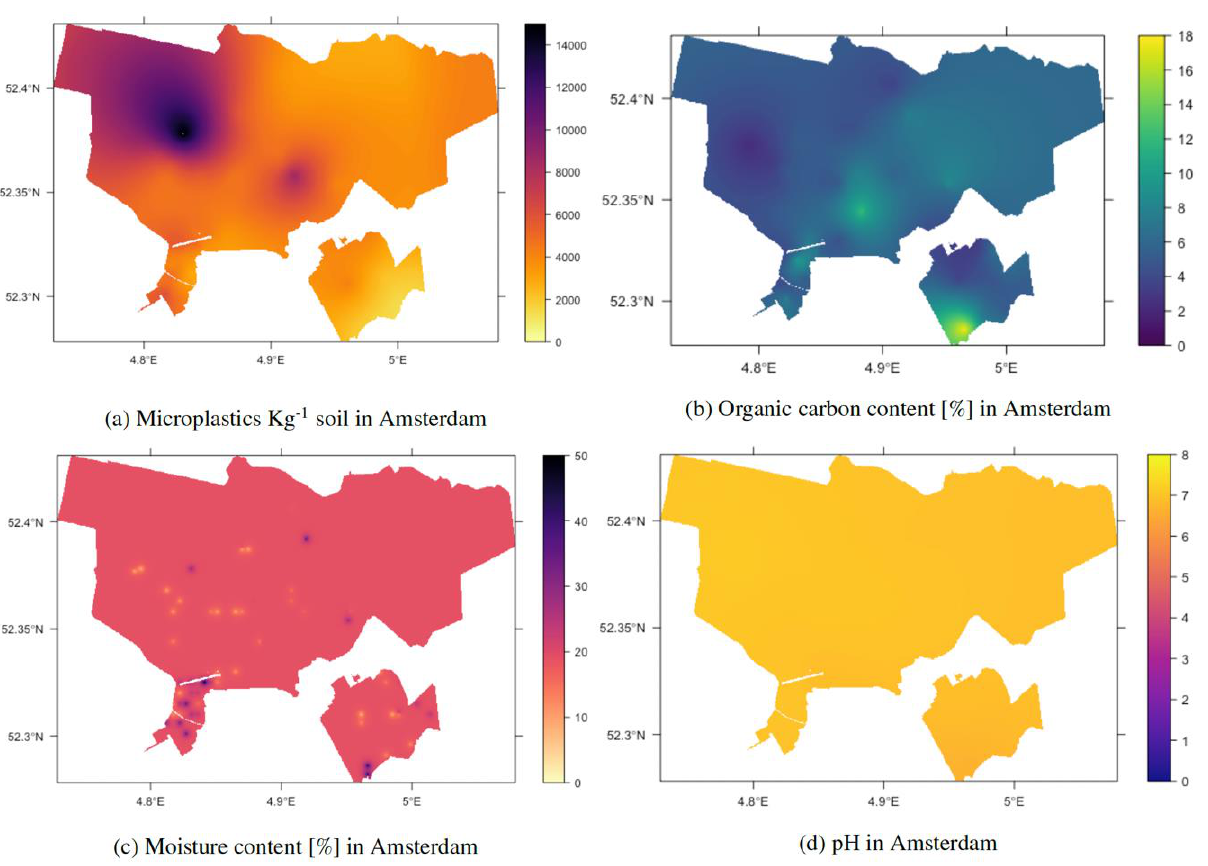
Figure 5. Prediction maps of ( a ) microplastic concentration (MPP/kg), ( b ) organic carbon content (%), ( c ) moisture content (%), and ( d ) pH in soils from parks and recreational areas of Amsterdam.